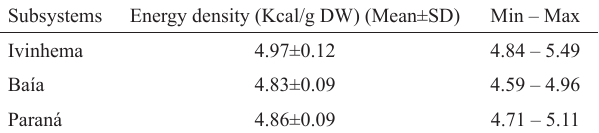
Table 4. Energy density (Kcal/g DW) of Hemiodus orthonops from the subsystems of the upper Paraná River